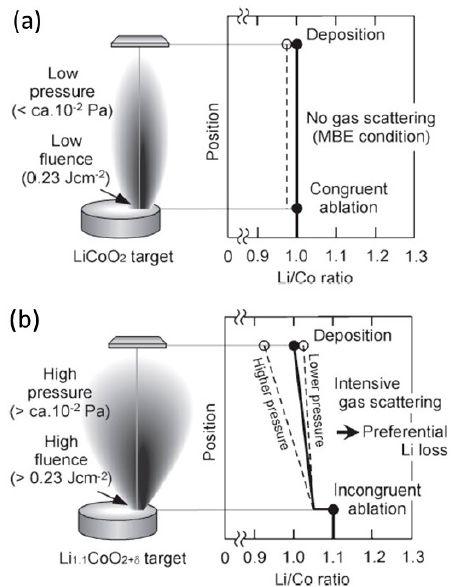
Figure 3. Schematic representation of the fast-laser ablation growth according to the Li/Co ratio variation of the plume for a stoichiometric ( a ) and Li-enriched target ( b ). (Reproduced with permission from [62]. Copyright 2012 IOP Publishing).